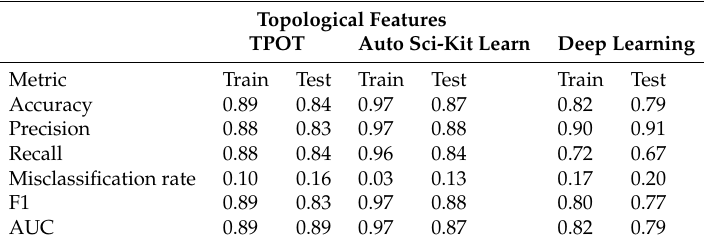
Table 2. Machine Learning Accuracy—Topological Features.